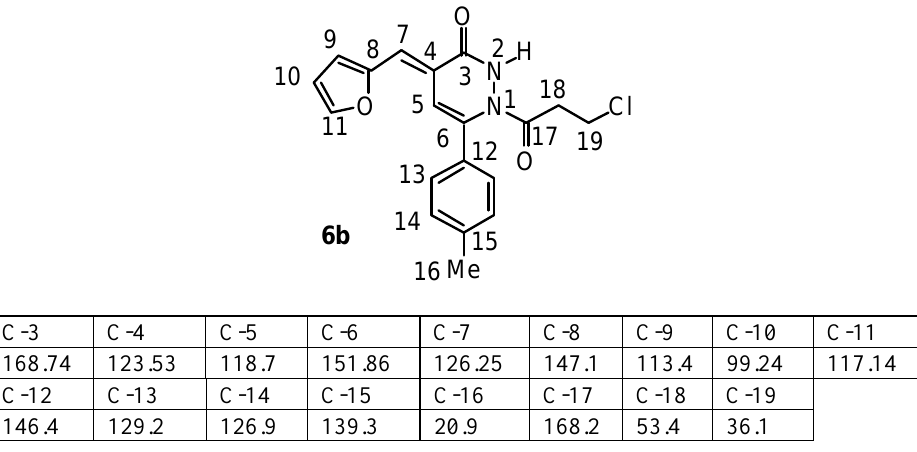
]DMSO) for 6-(4-methylphenyl)-1-(3-chloropropanoyl)-4-[( E 6